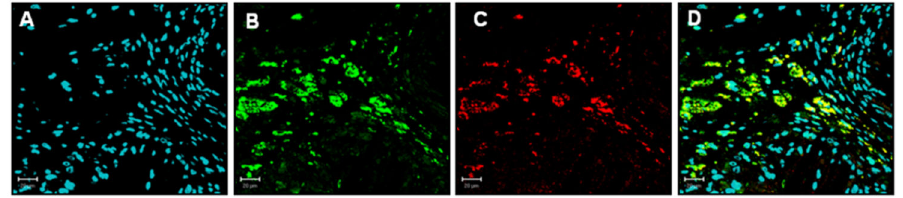
Figure 3. Macrophages and foam cells from atherosclerotic plaques express CD100. Immunofluorescence of carotid plaques with blue nuclei in DAPI (A), CD68 staining in FITC ( green , B), CD100 staining in Alexa 660 ( red , C) and co-localization of markers (D). Scale bars: 20µm. doi: